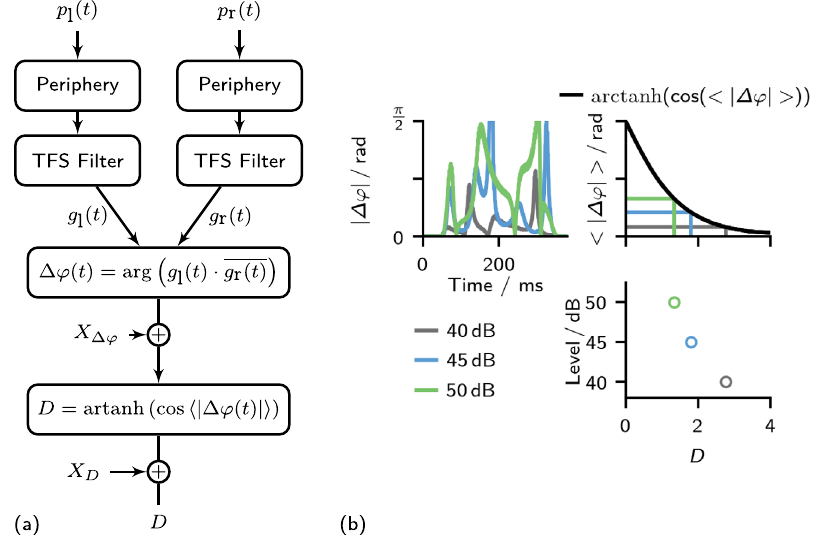
Figure 2. (a) Schematic of the proposed model. (b) Example of the decision stage for N 0 S p stimuli at different signal levels. The top left shows the absolute value of the instantaneous IPD over time. Increasing the target level (with an IPD of p ) increases fl uctuations and thus the mean absolute IPD ( y -axis top right). Taking the cosine of the mean IPD results in smaller output values with increasing IPD fl uctuations. The decision variable D results directly from the cosine, subject to a Fisher ’ s-Z transform, so that lower values indicate a stronger signal prevalence (bottom